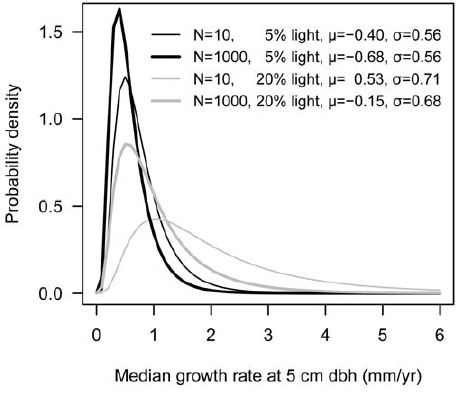
Figure 3. Distribution of median growth rates for rare and abundant species under different light conditions. The proba- bility distribution of median growth rate (mm/yr) at 5 cm dbh for rare (N=10) and abundant (N=1000) species at low (5%) and high (20%) light is calculated from the hyperparameters of a and b for the census interval